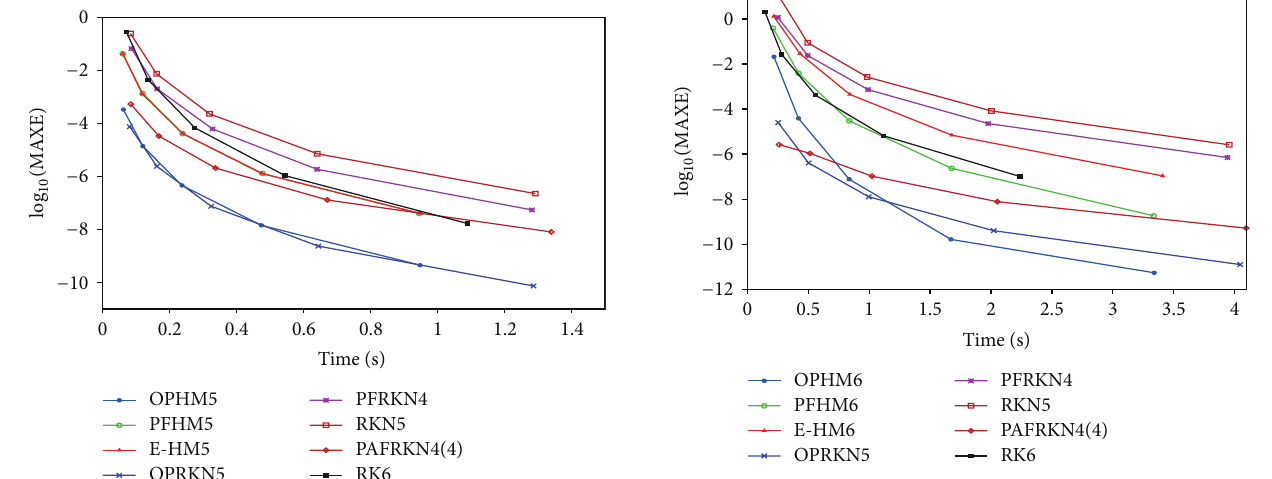
= 10 4 and ℎ = 0.125/ end